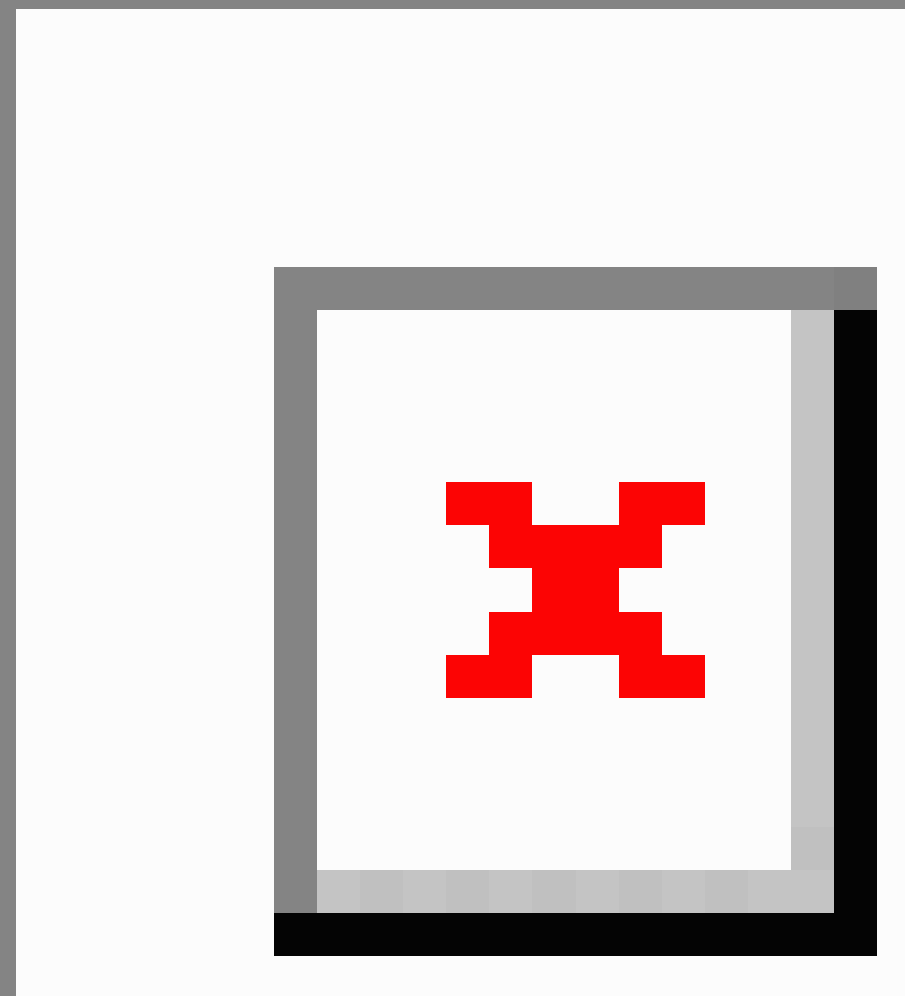
Figure 3. A comparison of long-term reviews and other